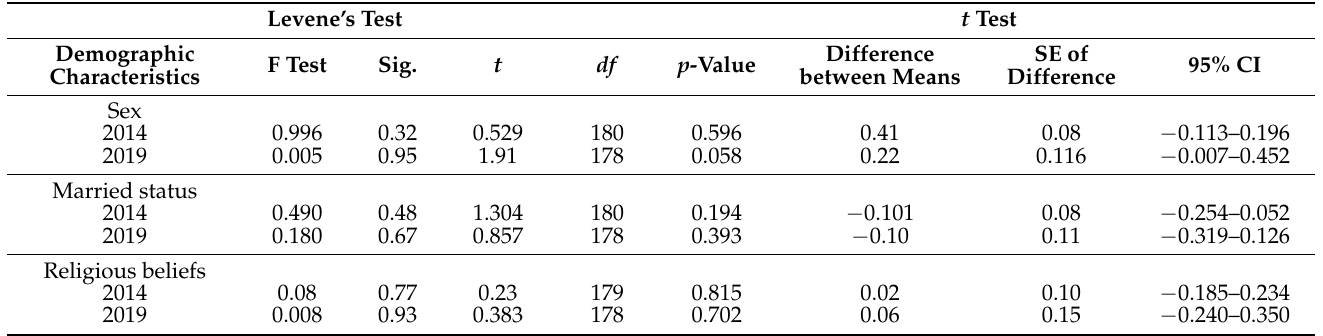
Table 2. F test and t test of depression risk in sex, marital status, and religious beliefs. Levene’s Test t